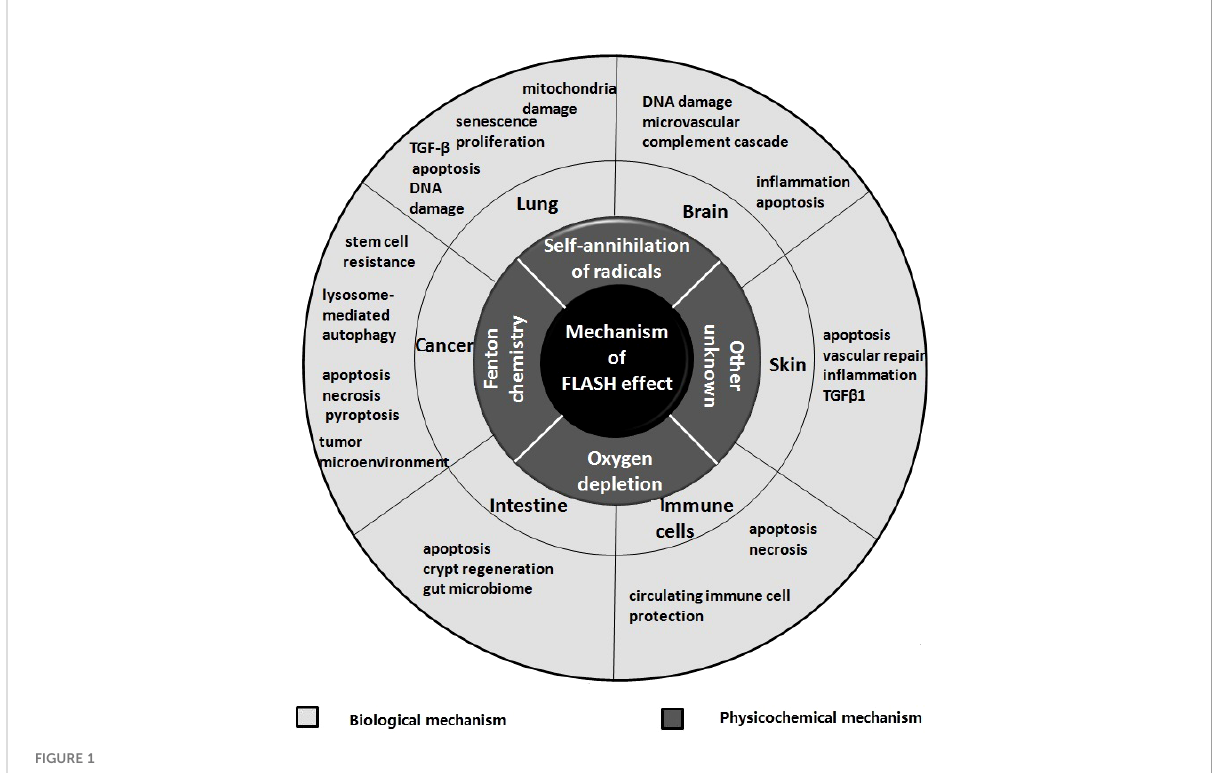
FIGURE 1 Themechanisms of FLASH